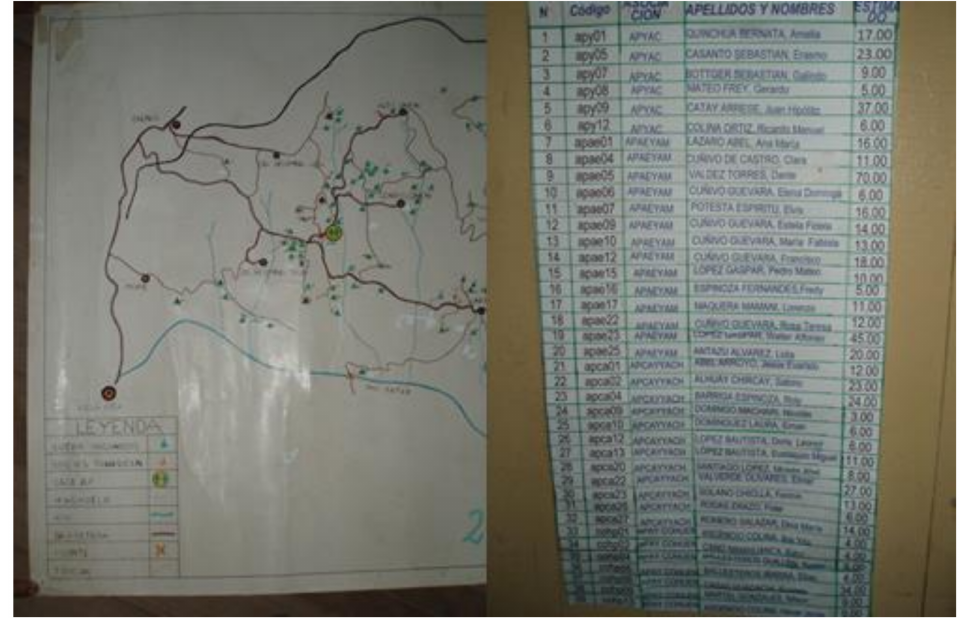
Figure 6. State before starting mapping project—hand-drawn maps and tables of co ff ee plantations.